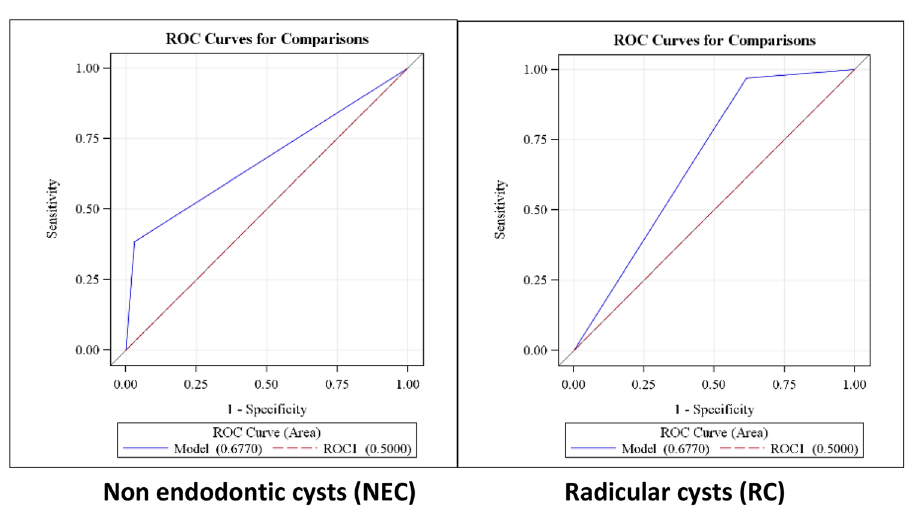
Figure 2. ROC charts for RC and